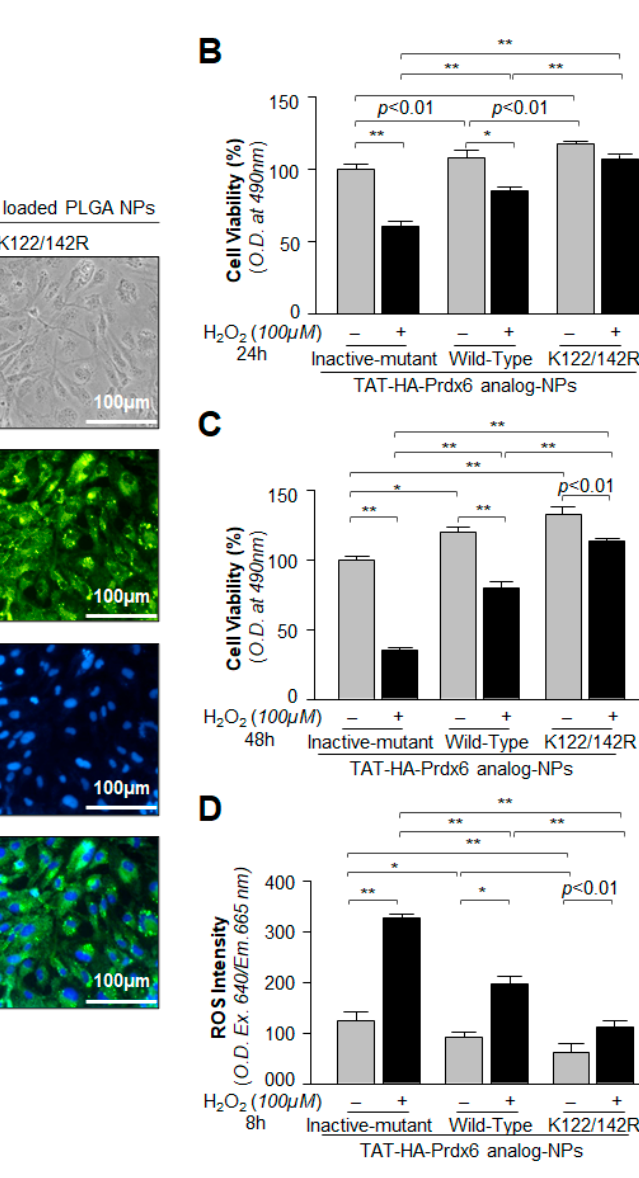
Figure 4. Analysis of Prdx6 analog-loaded PLGA-NPs cellular internalization and evaluation of cytoprotective potential against H 2 O 2 -induced oxidative cell death. ( A ) A representative of photomicrographs displaying the internalization of Prdx6 analog-loaded PLGA-NPs (with Coumarin-6, a fluorescence marker) in hLECs as indicated. ( B – D ) hLECs treated with Sumoylation-deficient protein TAT-HA-Prdx6 K122/142R -NPs engendered higher resistance against oxidative stress than TAT-HA-Prdx6 WT -NPs. hLECs were incubated with TAT-HA-Prdx6 WT and its mutant proteins loaded NPs for 6h as indicated; then, the cells were tryspinized and harvested on coverslips to take photomicrographs or in 96-well plates for ROS and MTS analyses. Then, 24 h later, hLECs were exposed to 100 µM of H 2 O 2 , as indicated in figure. After 8 h, ROS intensity was measured with CellROX deep red reagent ( D ), and 24 h and 48 h later, cell viability was analyzed by MTS assay ( B , C ). Histogram values represent the mean ± SD from three independent experiments. TAT-HA-Prdx6 Inactive-mutant -NPs vs. TAT-HA-Prdx6 WT -NPs and TAT-HA-Prdx6 K122/142R -NPs; TAT-HA-Prdx6 WT -NPs vs. TAT-HA-Prdx6 K122/142R -NPs; * p < 0.05 and ** p < 0.001.